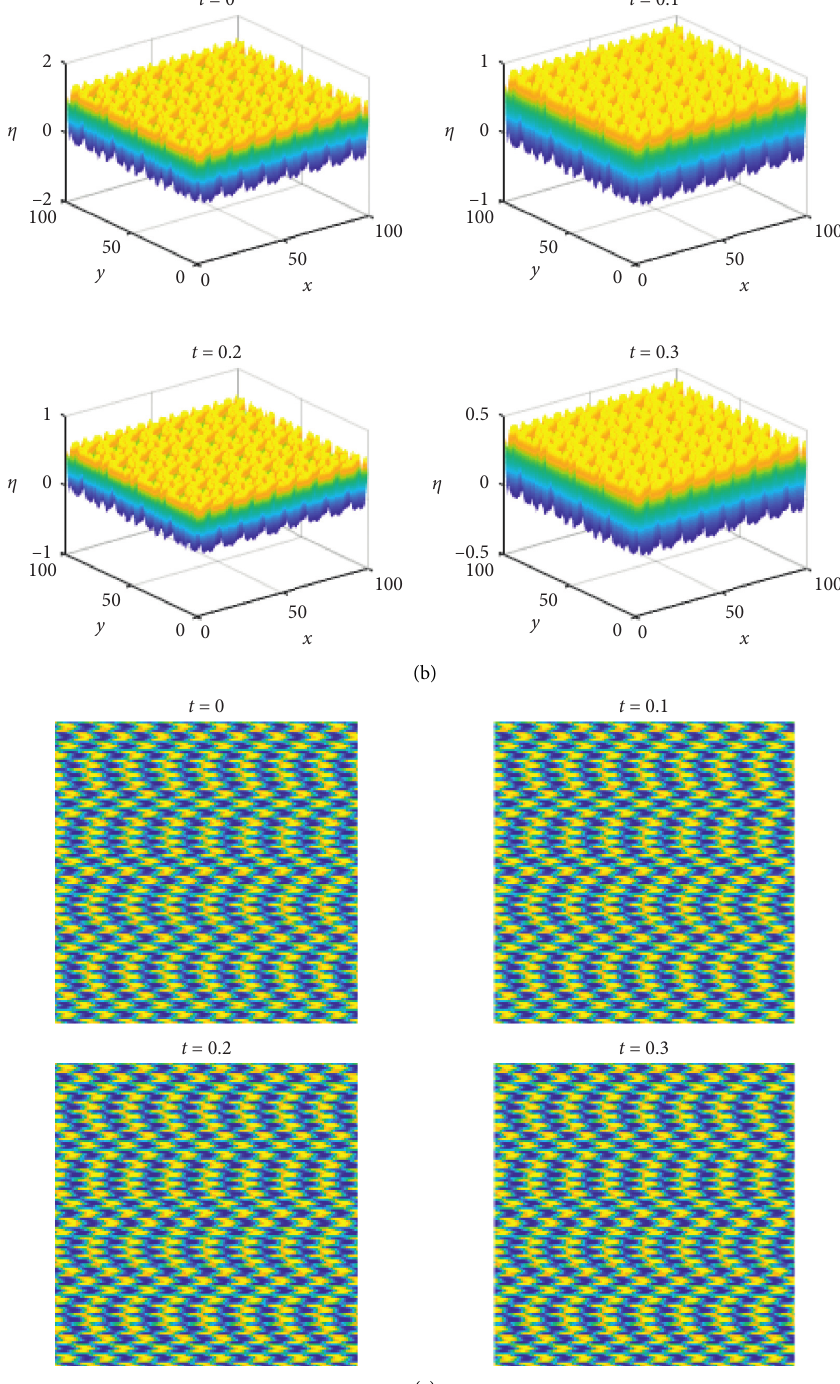
Figure 4: Numerical solution and pattern of Experiment 1 with initial condition η ( x,y, 0 ) � sin ( cos (( x /2 ) + y 2 )) + 0 .